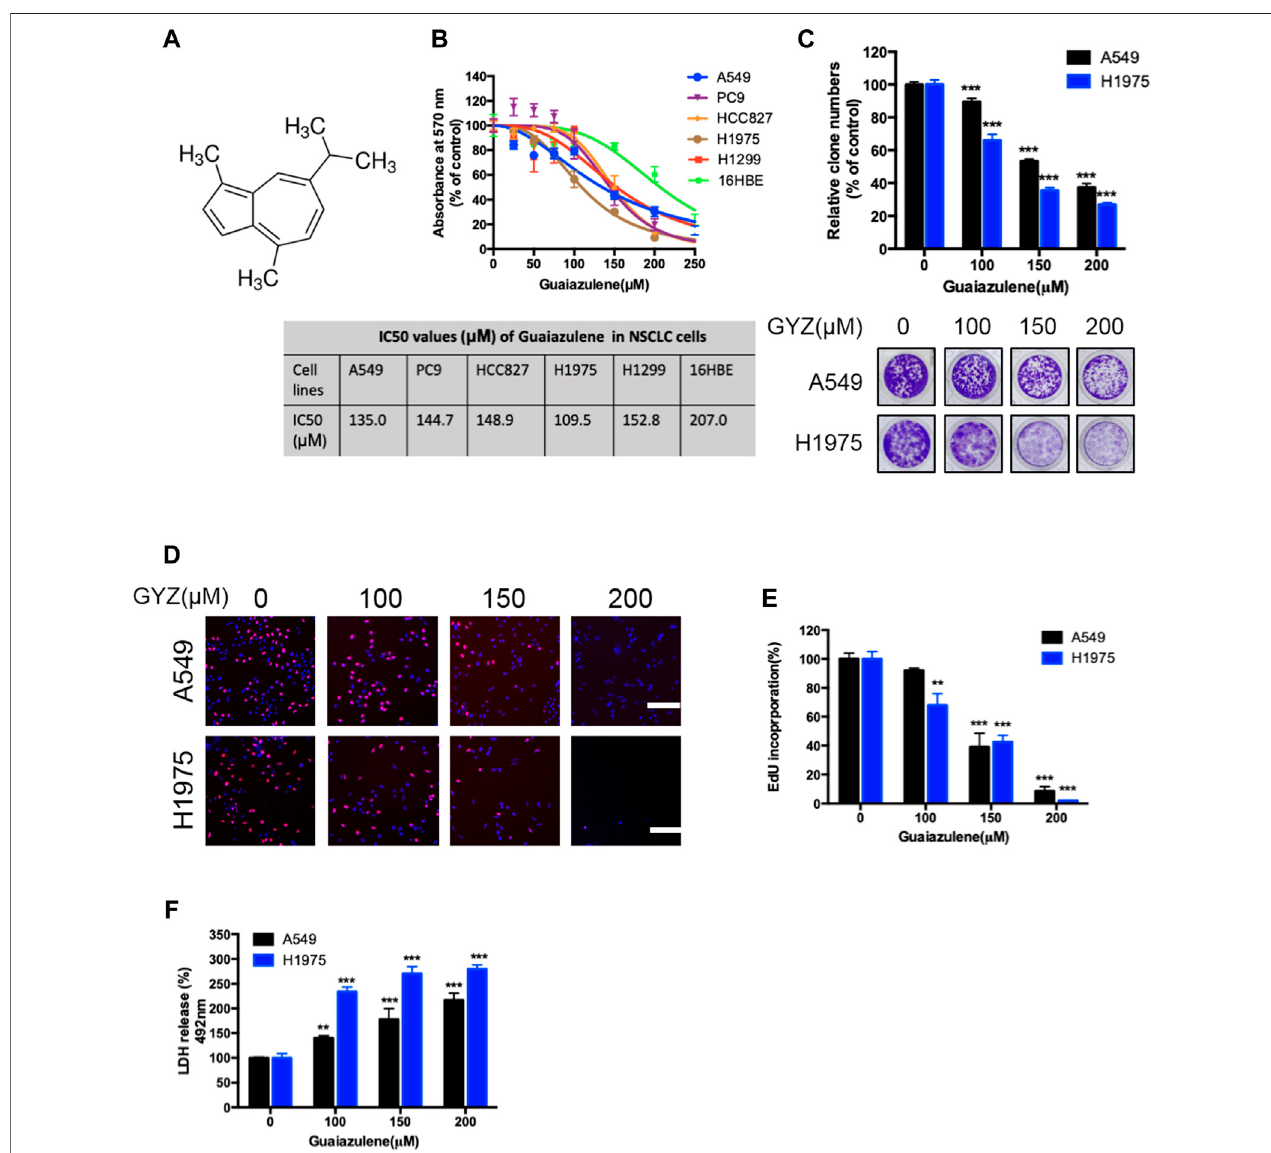
FIGURE1| GYZinhibits thegrowth ofNSCLC cells invitro . (A) Chemicalstructure ofGYZ. (B) NSCLC cells weretreated withGYZat theindicated concentrations for 48 h, and cell growth was measured by MTT assay. (C – E) A549 cells and H1975 cells were treated with GYZ at the indicated concentrations (the tested doses of guaiazuleneweredeterminedbytheIC50values).Cellproliferationwasperformedbycolonyformation (C) andEdUincorporation (D,E) assays. (F) Cellsweresubjected to GYZ for 48 h, and cytotoxicity was examined by the release of LDH.